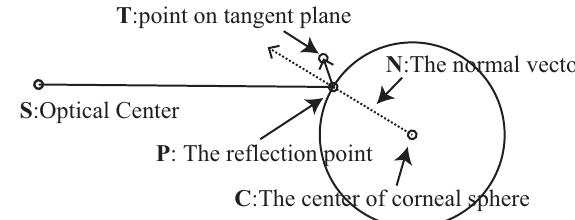
Figure 7 . Geometric model of reflection on the corneal surface.